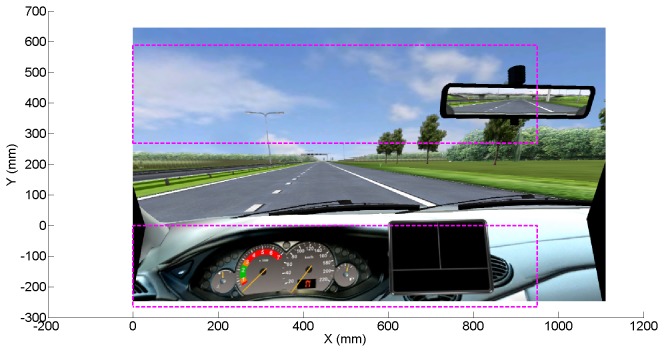
Illustration of top and bottom regions (inside dashed rectangles) used for calculating the eye-scanning measures.